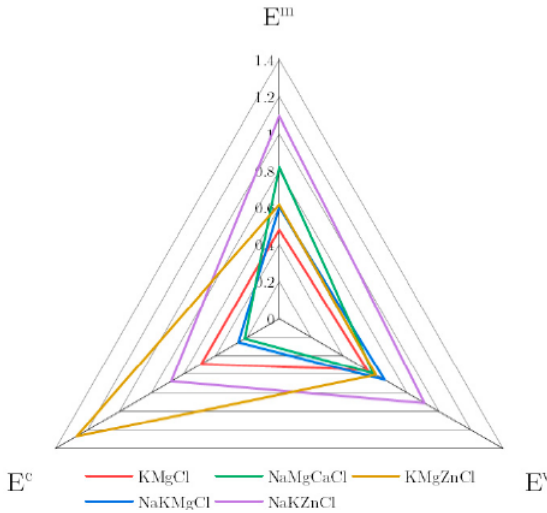
Figure 2. Chloride-based TES materials KPIs comparison (Solar Salt =